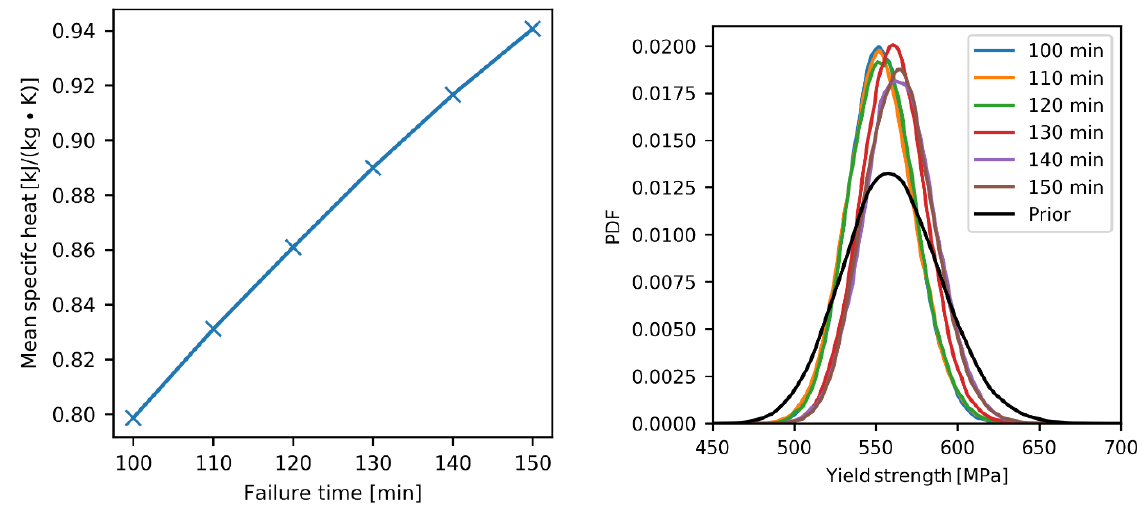
Figure 3. Posterior mean value of the specific heat of concrete at ambient temperature in function of the failure time (left); posterior distributions of the reinforcement steel yield strength at ambient temperature for different values of the failure time (right).